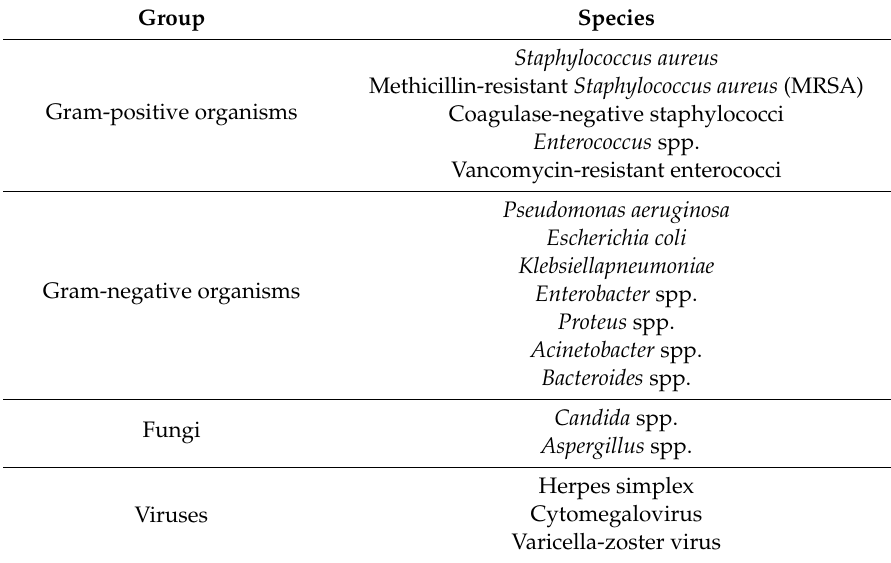
Table 1. Microorganisms that cause invasive burn wound